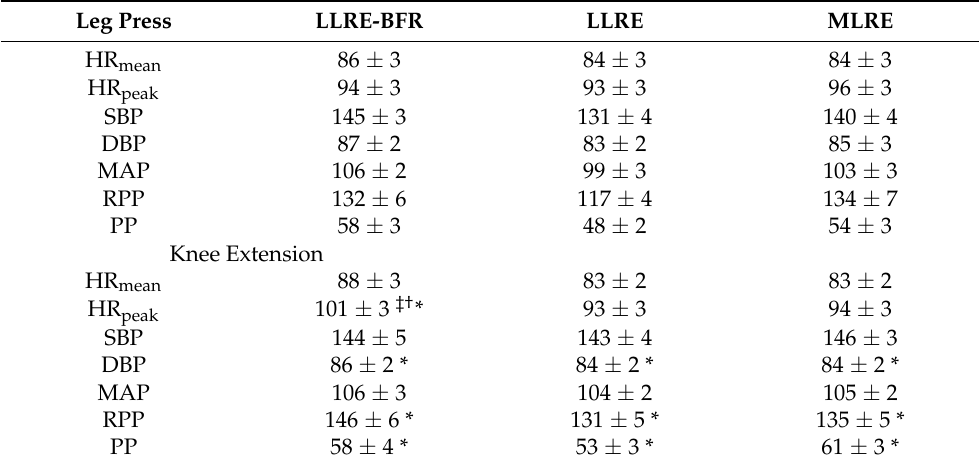
Table 2. Cardiovascular responses to leg press and knee extension.